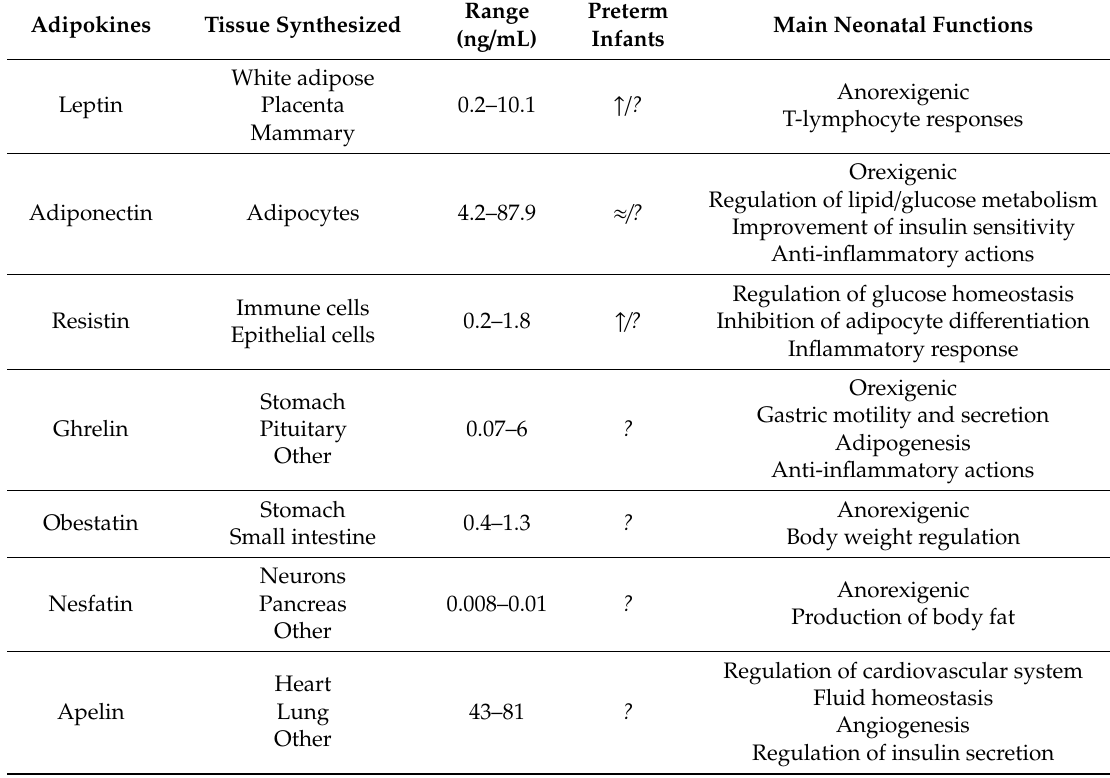
Table 4. Adipokines in human